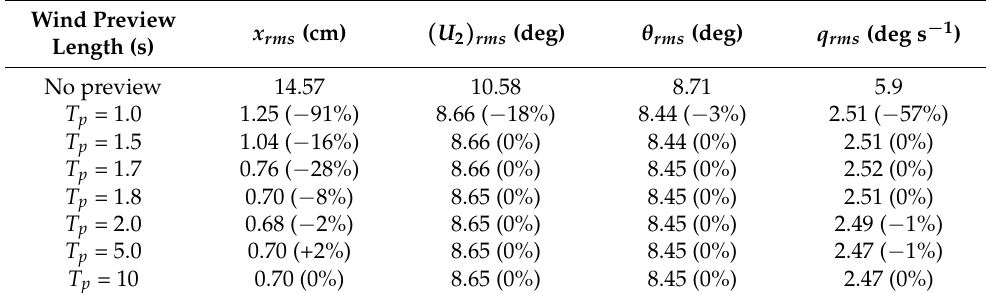
Table 4. Root-mean-square (rms) values of position, MPC pitch demand, pitch response, and pitch rate for different wind preview